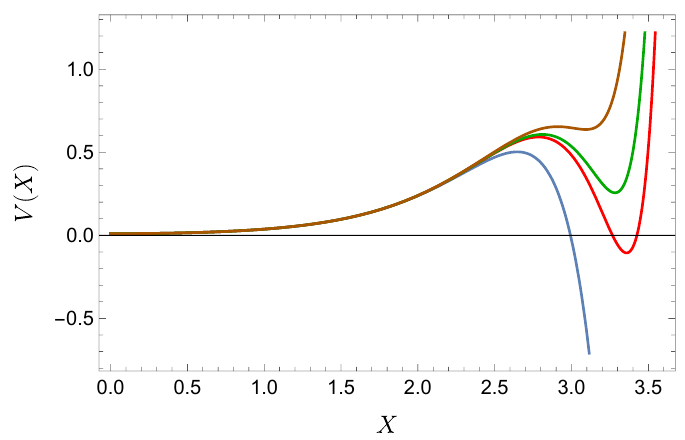
Figure 2 . Potential for X , in the presence of a scalar, with DD boundary conditions. The parameters chosen are ‘ uv = 10 , ‘ ir = 9 . 9 , (cid:15) = 10 − 2 , v ir = 10 − 3 and 1000 v uv = 2 (red), 2 . 05 (green) and 2 . 15 (brown), with 12 M 3 /k = 1 . Also shown is the potential without the scalar contribution 5 (blue), with the unstable extremum. The effect of the scalar dynamics is to increase X ∗ , and generate a meta-stable dS